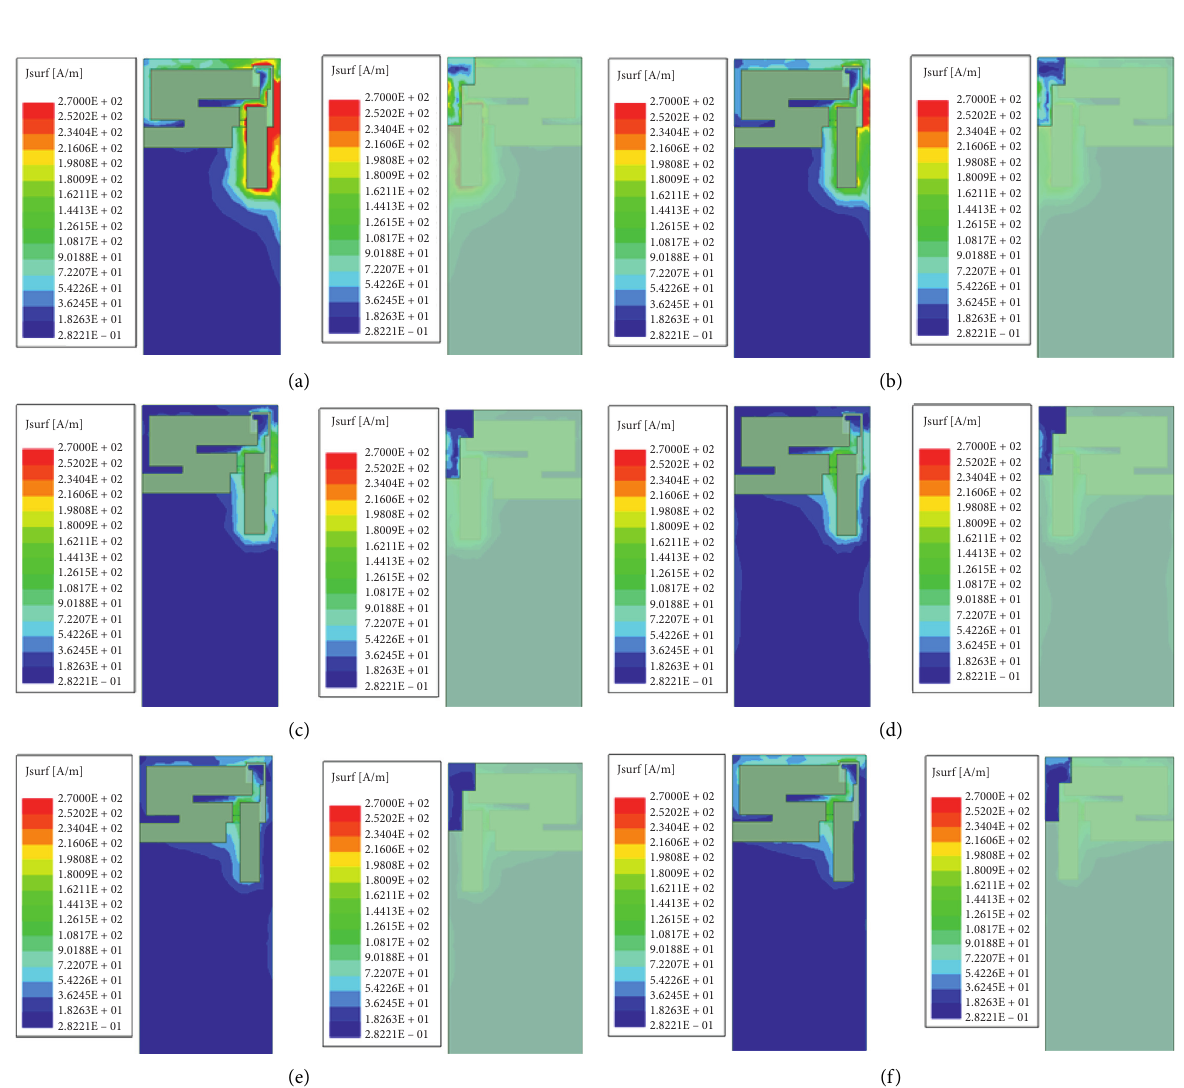
Figure 2: The surface current distributions at different operating frequencies: (a) 2350MHz; (b) 2450MHz; (c) 2600MHz; (d) 3050MHz; (e) 3500MHz; (f)